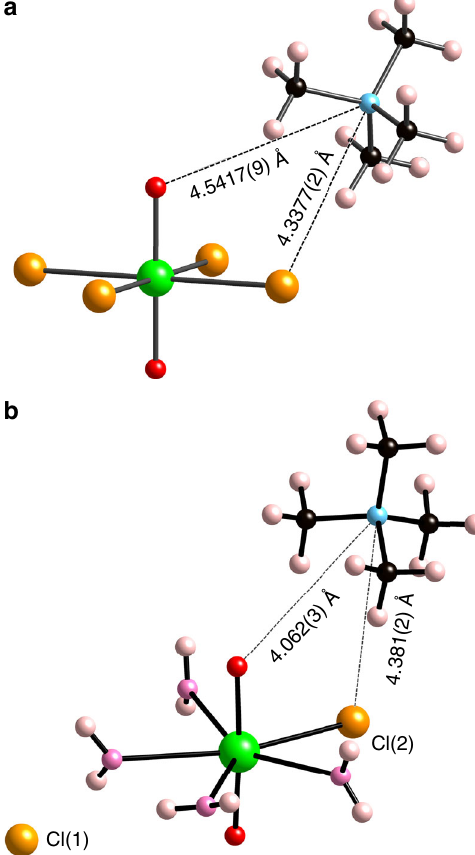
Fig. 4 Structures of Np VI – and Np V – [NMe 4 ] chlorides. a Local connectivities between one crystallographically unique Np VI O 2 2 + cation, one Cl − anion, and one [NMe 4 ] + cation in the structure of [NMe 4 ] 2 [NpO 2 Cl 4 ] ( 2 ). b Local connectivities between one crystallographically unique Np V O 2 + cation, two Cl − anions, four water molecules, and one [NMe 4 ] + cation in the structure of [NMe 4 ]Cl[NpO 2 Cl(H 2 O) 4 ] ( 3 ). Green, red, pink, orange, blue, black, and beige spheres represent Np, O yl , O w , Cl, N, C, and H atoms,